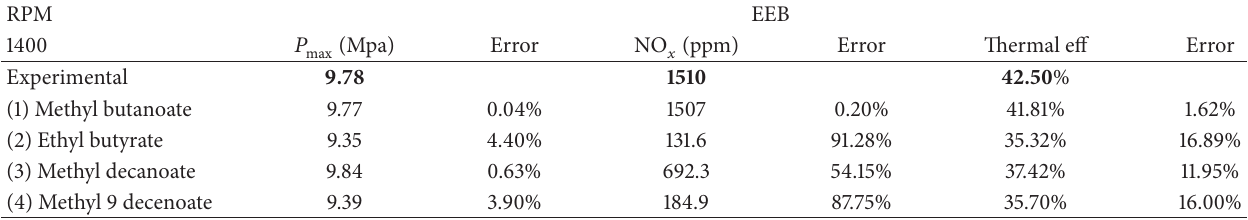
Table 8: Comparative experimental and simulated results for ethyl ester biodiesel and each surrogate at 1400 rpm.